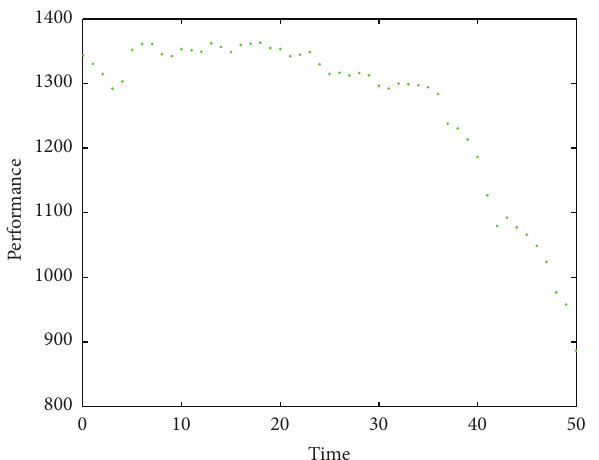
Figure 8: Resilience of cluster supply chain with self-organization recovery mechanism.